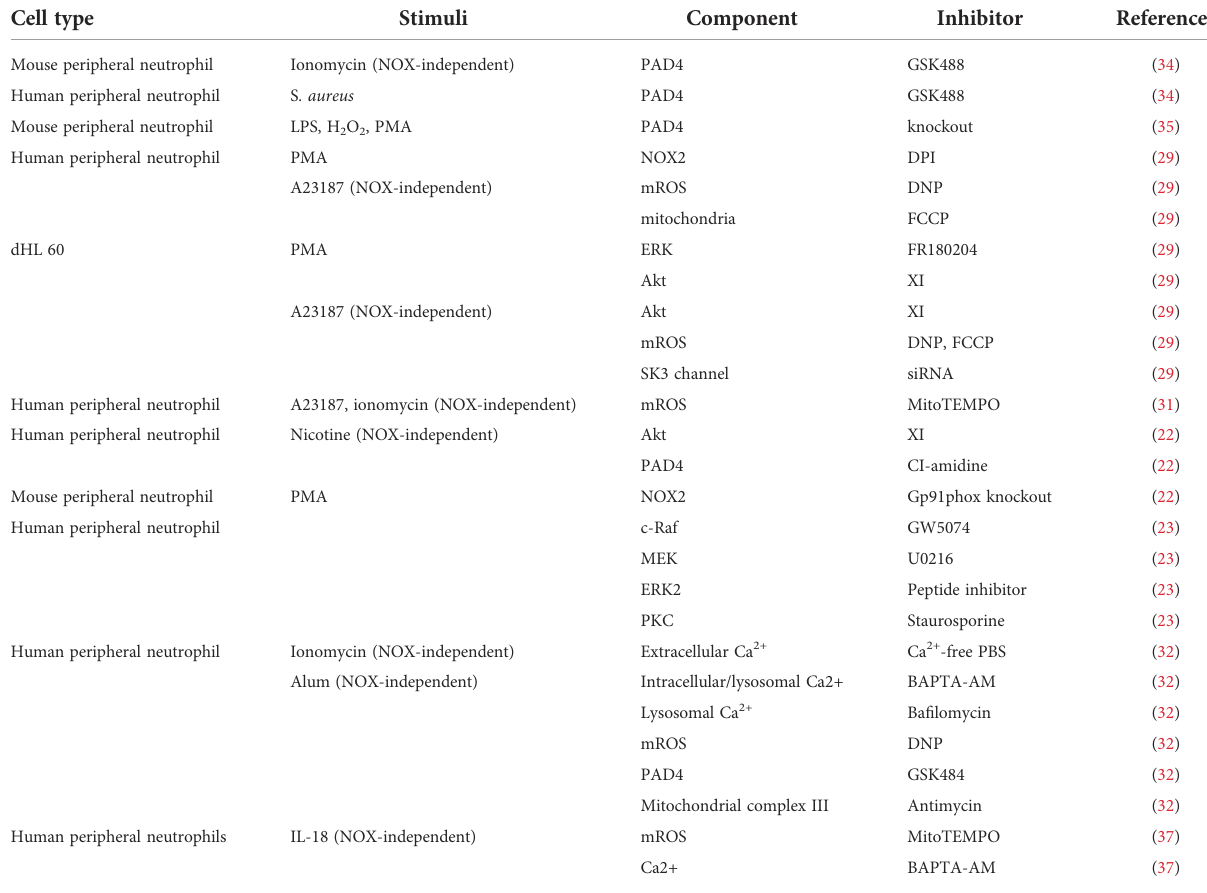
TABLE 1 NETosis